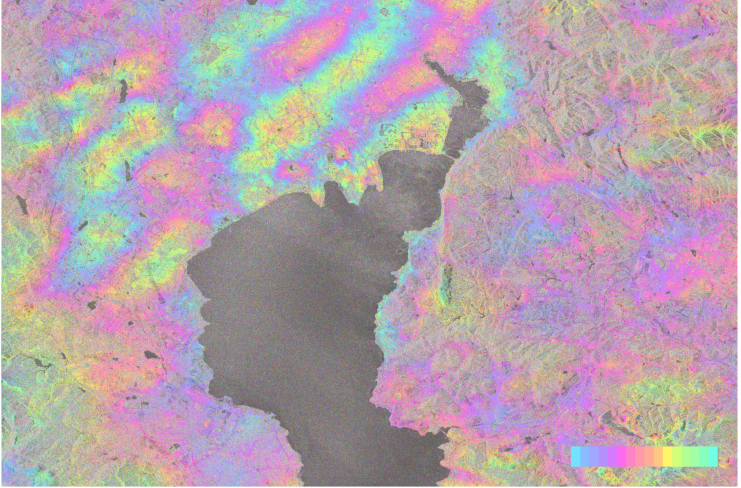
Figure 10. A certain differential interferogram before filtering using Doris to generate the study area.